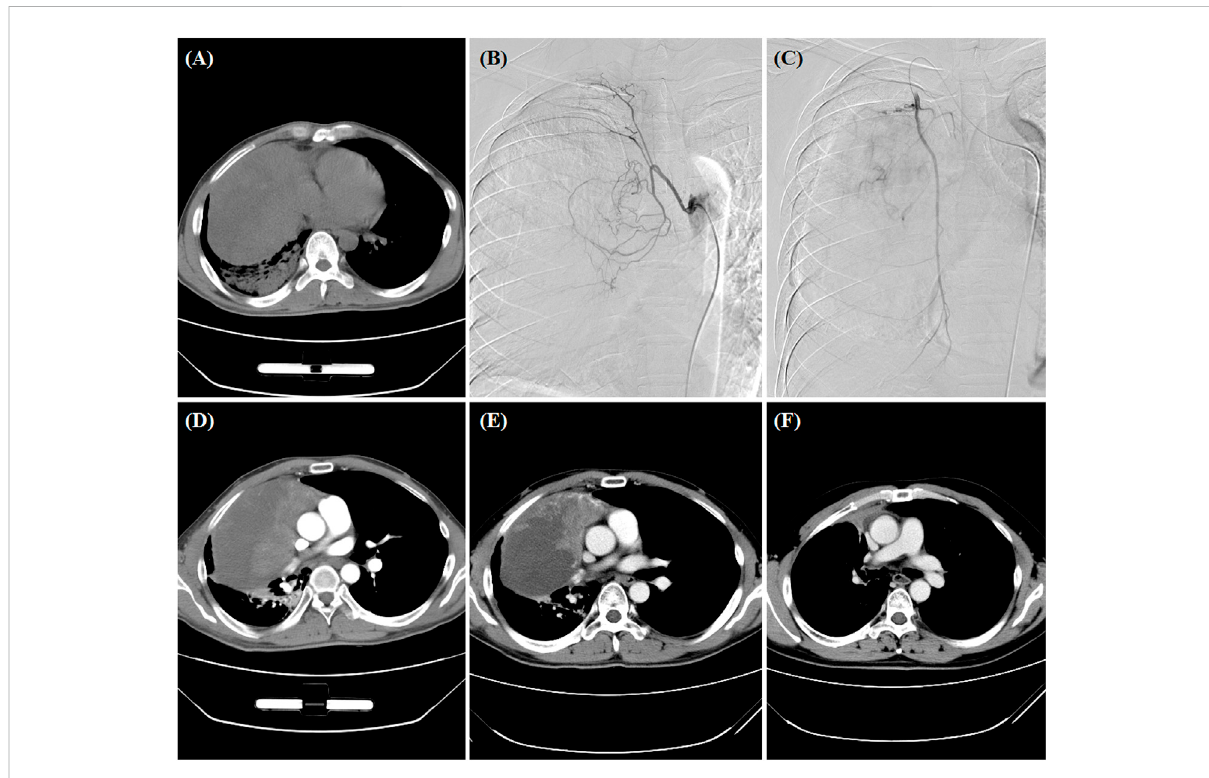
FIGURE 2 A34-yearmantreatedbyDEB-TACE. (A) CTpre-procedureexaminationrevealedalargetumoroftherightlung. (B,C) Therightbronchialartery and the right intercostal artery were the blood supply artery of the tumor. (D,E) The lung tumor was found to shrink at 1- and 3-month follow-up. (F) Surgical resection was performed after 3.6 months.